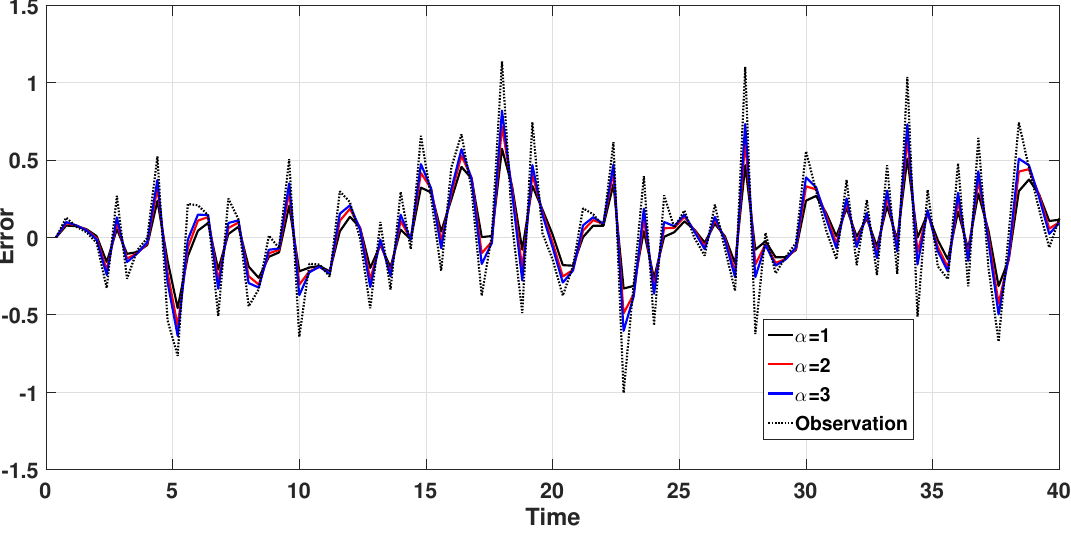
Figure 4. Errors with different α values. Table 1. Comparison with different α